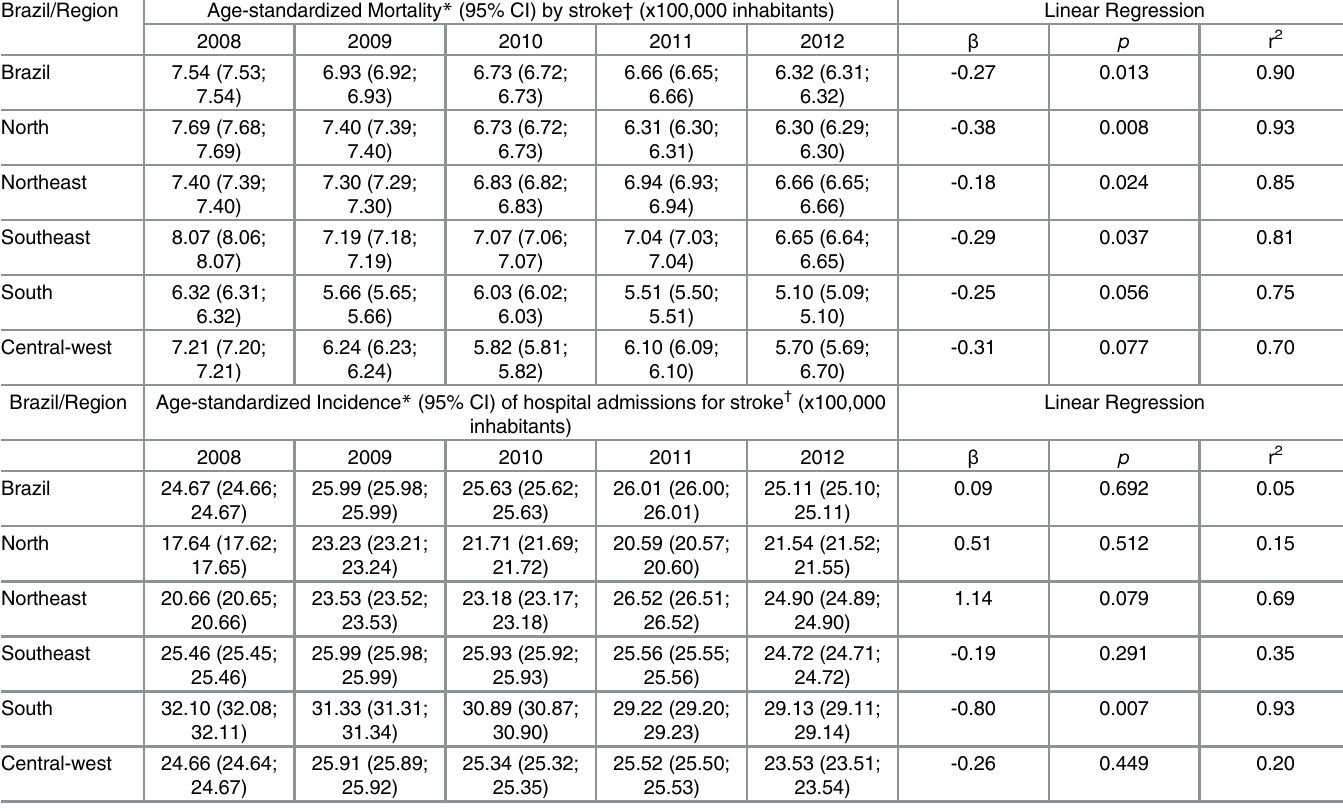
Table 2. Mortality * and incidence * of hospital admissions for stroke † (95% confidence interval) per 100,000 inhabitants; and estimates of linear regression (referring to the rates) in Brazilians aged 15 to 49 years between 2008 and 2012, according to country regions and year.